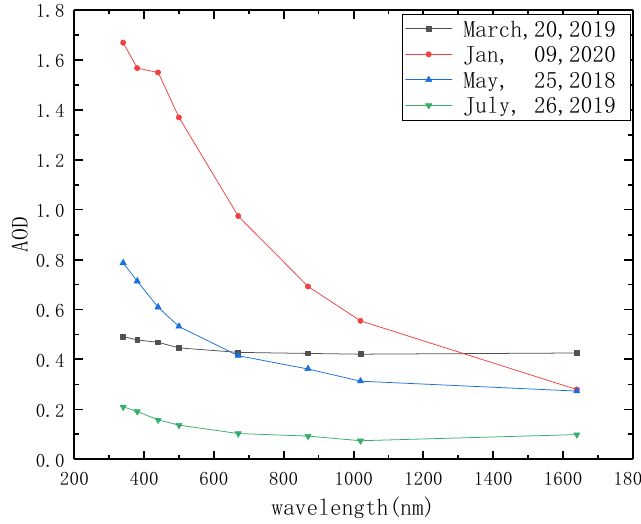
Figure 4. The AODs on hazy days, dusty days and sunny days.